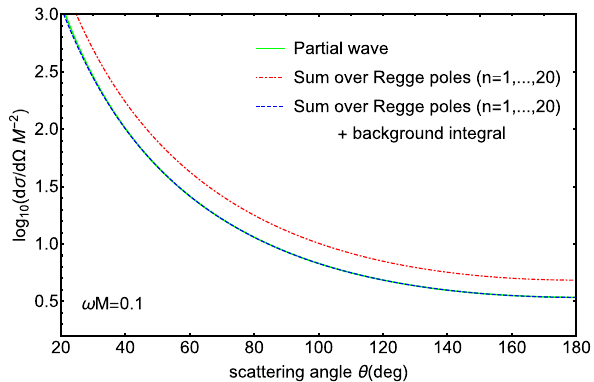
Fig. 10 Comparison of the partial wave result of the scattering cross section with its Regge pole approximation with and without the back- ground integral. The parameters are the same as those in Fig. 9 (with ω M = 0 . 1)